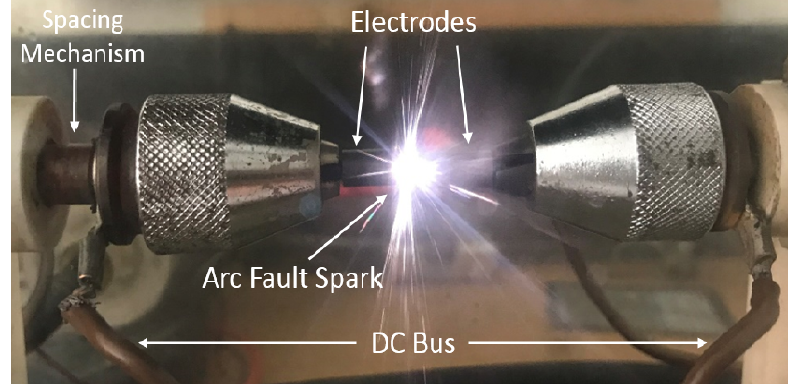
Figure 3. UL1699B-based AF generator mechanism.